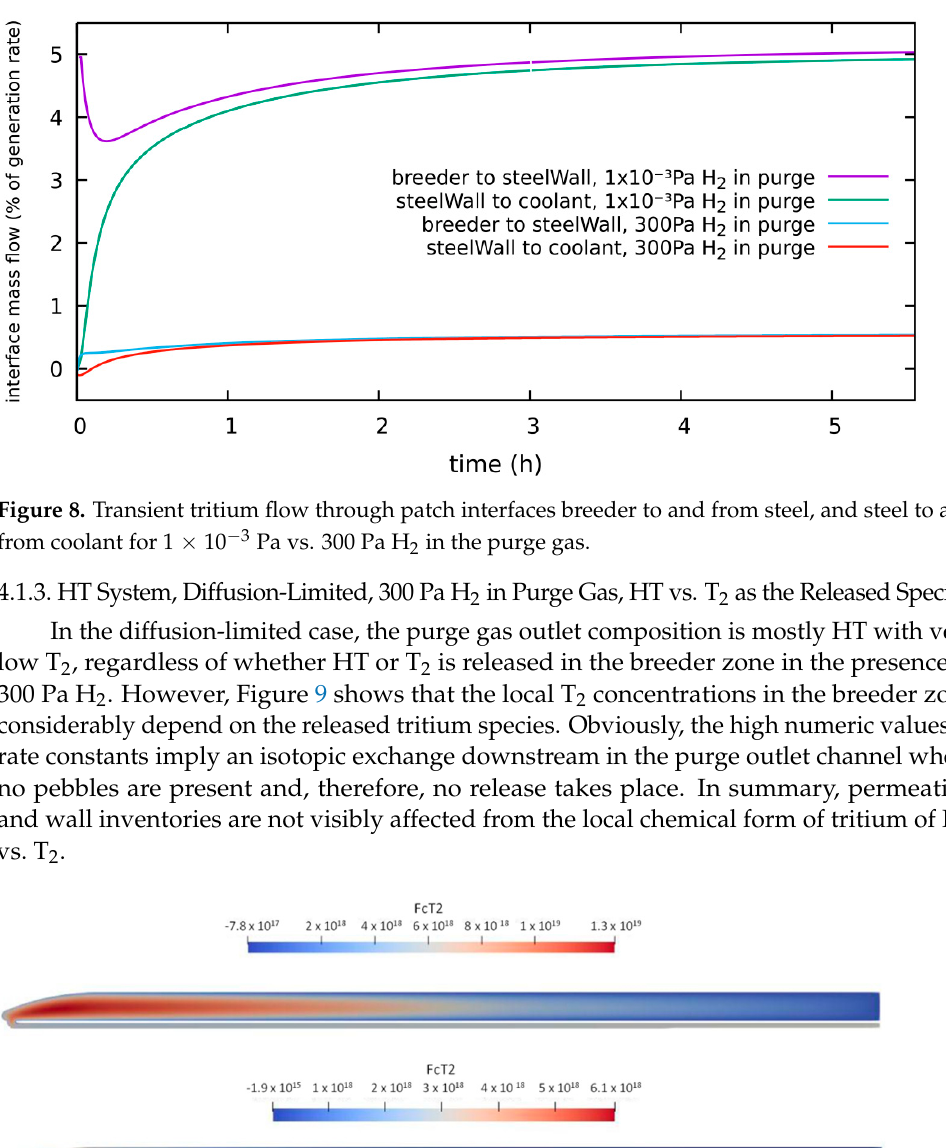
Figure 7. Transient T 2 and HT partial pressure at coolant outlet for 1 × 10 − 3 Pa vs. 300 Pa H 2 in the purge gas.